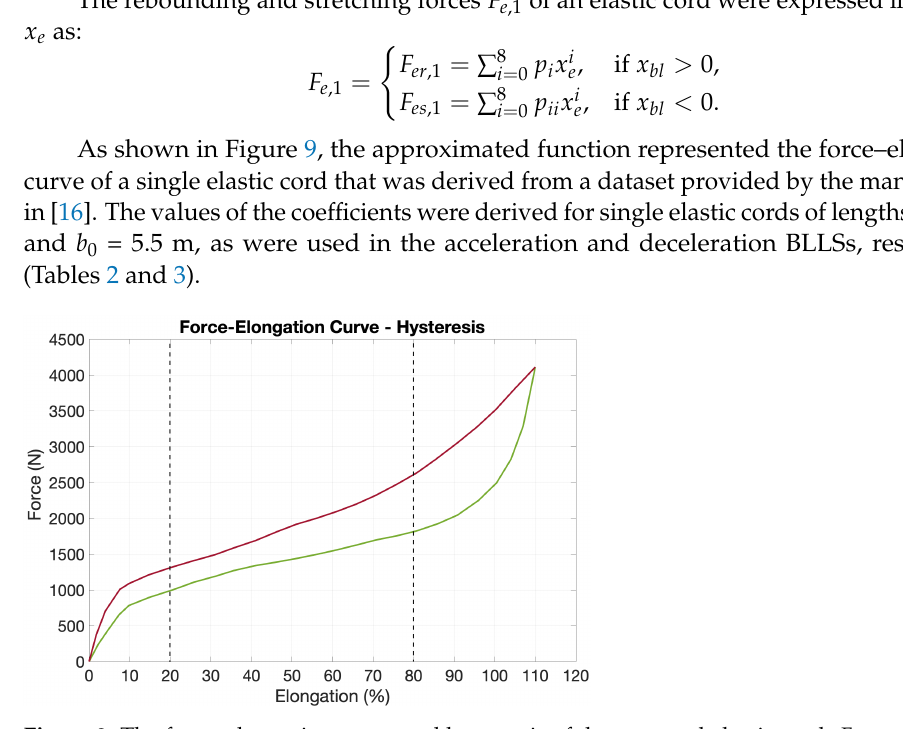
Figure 9. The force–elongation curve and hysteresis of the assumed elastic cord. F er ,1 and F es ,1 are indicated in green and red, respectively. Table 2. The coefficients of the F er ,1 approximation function (rebound force) for elastic cords of 5 m and 5.5 m in